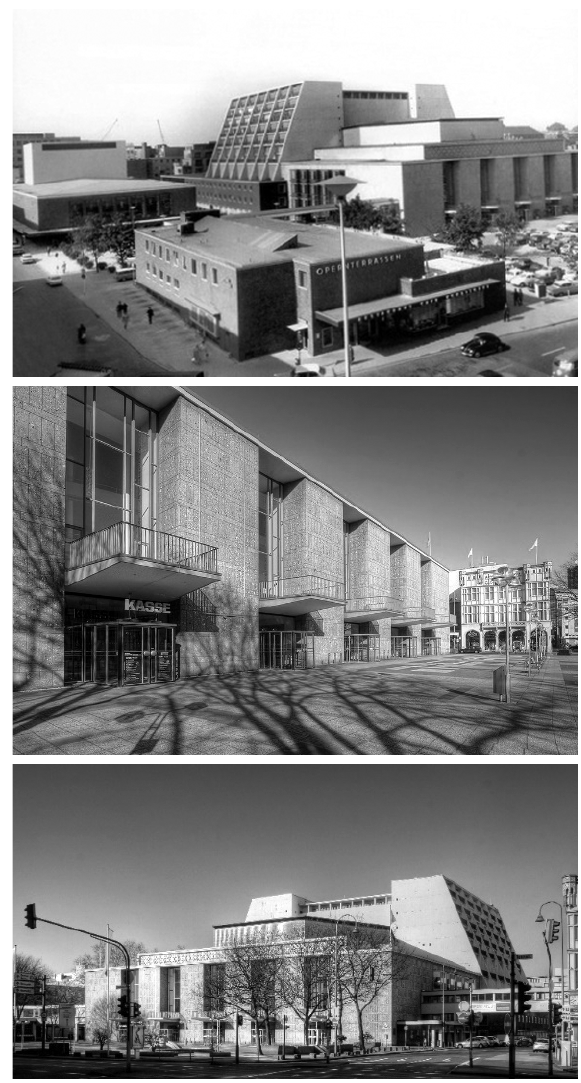
Figure 21. Top: W. Riphahn, Historical image of Kölner Oper , 1957 (Vakdad, 2018). Middle and bottom: Modern image of Kölner Oper (Spekking,